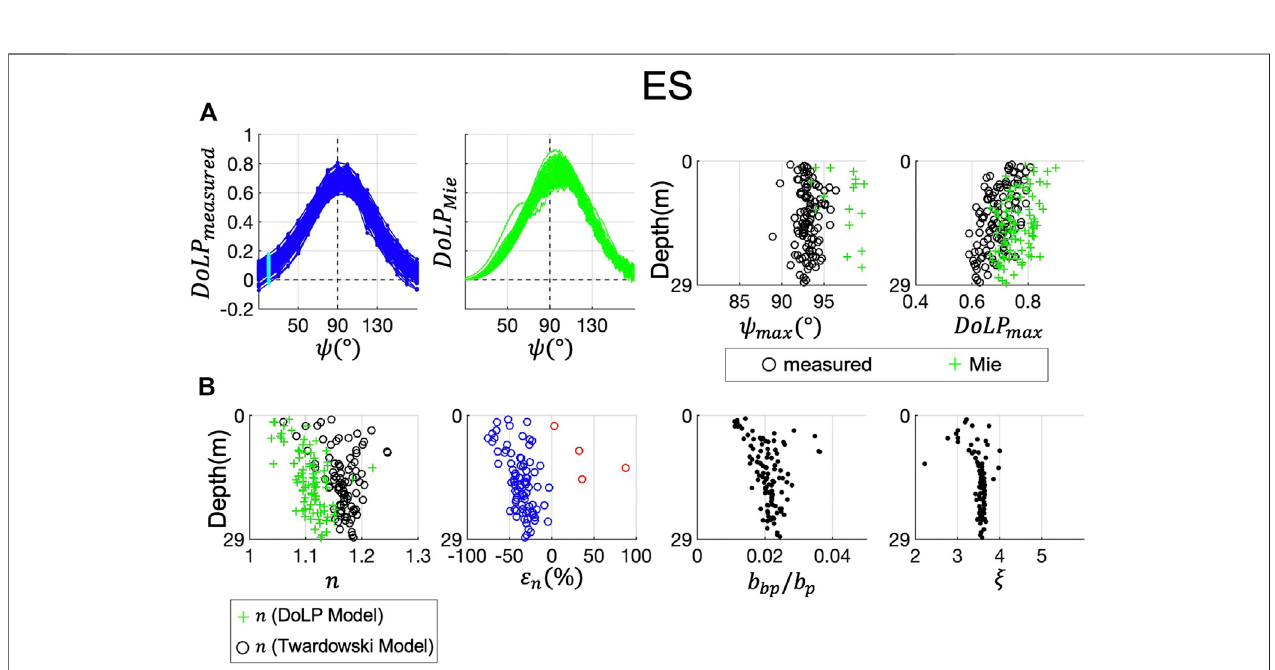
FIGURE9| Particulate refractive index retrieval at fi eldsite ES(EastSound). (A) Fromleft toright: Measured particulateDoLP ( DoLP measured ).The best fi tsimulated DoLP ( DoLP Mie ) corresponding to each measured DoLP. Comparison of ψ max and DoLP max of the measured and simulated DoLP. (B) From left to right: Retrieved refractive indices of the Twardowski model and the DoLP model. Relative error ( ε n ) of the decimal parts of the two refractive indices. Backscattering ratio b bp / b p used in the Twardowski model. PSD slope ξ used in both models.